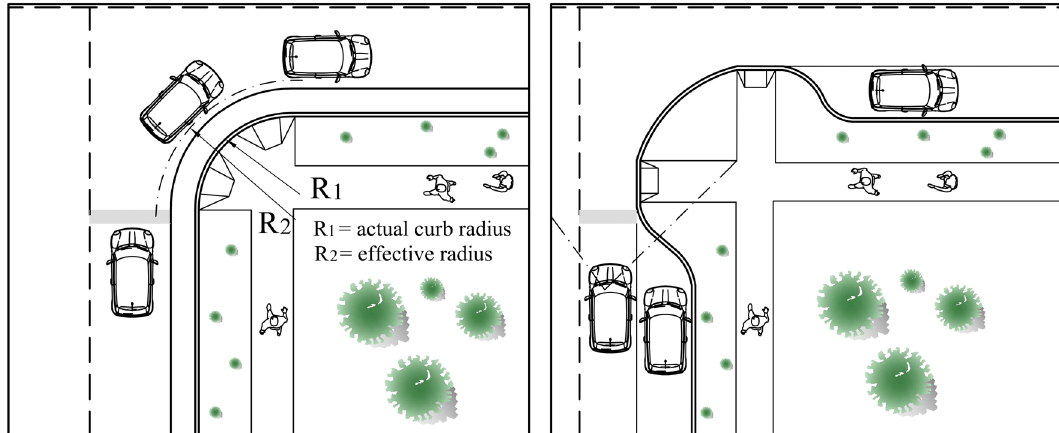
Fig. 8 Geometric modifications of a road intersection by sidewalk